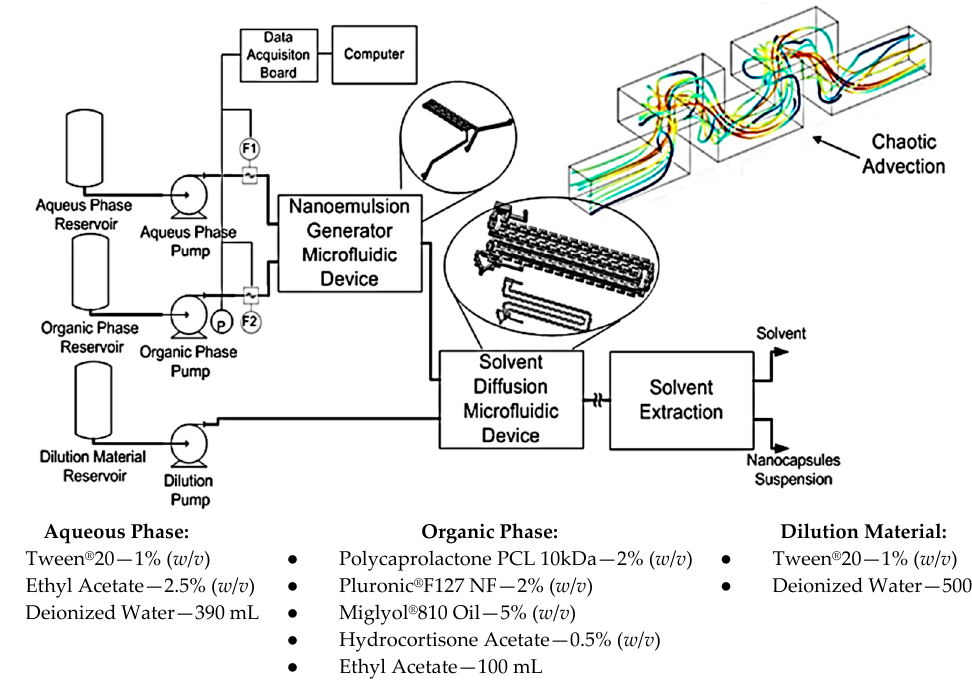
Figure 19. Layout for generation of nanocapsules through a continuous regime microfluidic system.